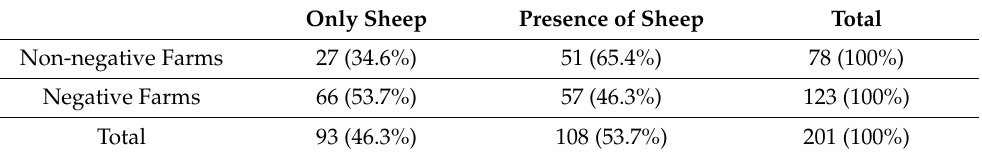
Table 2. Distribution of negative and non-negative farms by presence of sheep within the farm. Only Sheep Presence of Sheep Total Non-negative Farms 27 (34.6%) 51 (65.4%) 78 (100%) Negative Farms 66 (53.7%) 57 (46.3%) 123 (100%) Total 93 (46.3%) 108 (53.7%) 201